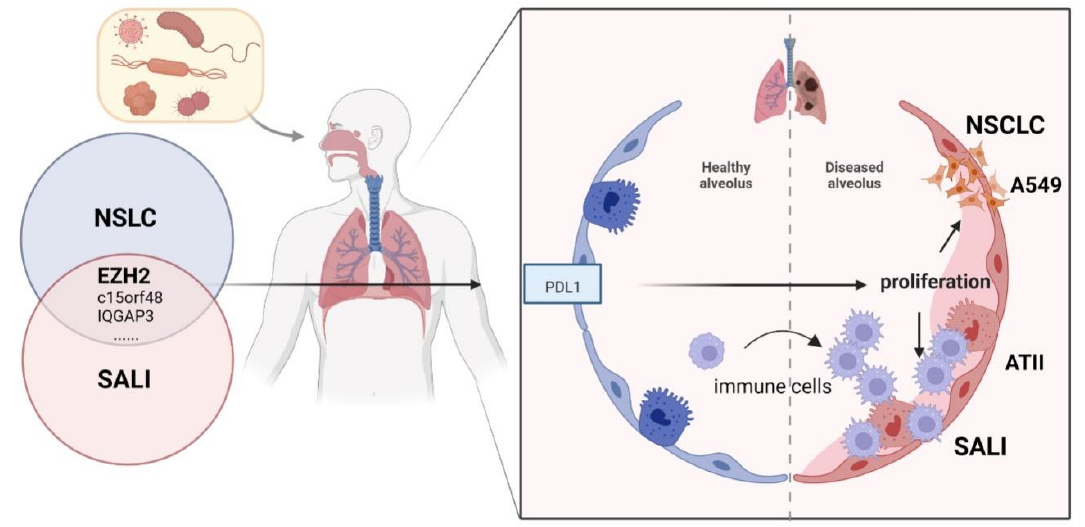
Figure 7. Overview of the interactions between SALI and NSCLC. The shared genes of SALI and NSCLC regulate PBMC and ATII apoptosis to enhance SALI and are involved in cancer-related pathways that promote NSCLC development. SALI, sepsis acute lung injury; NSCLC, non-small-cell lung cancer.